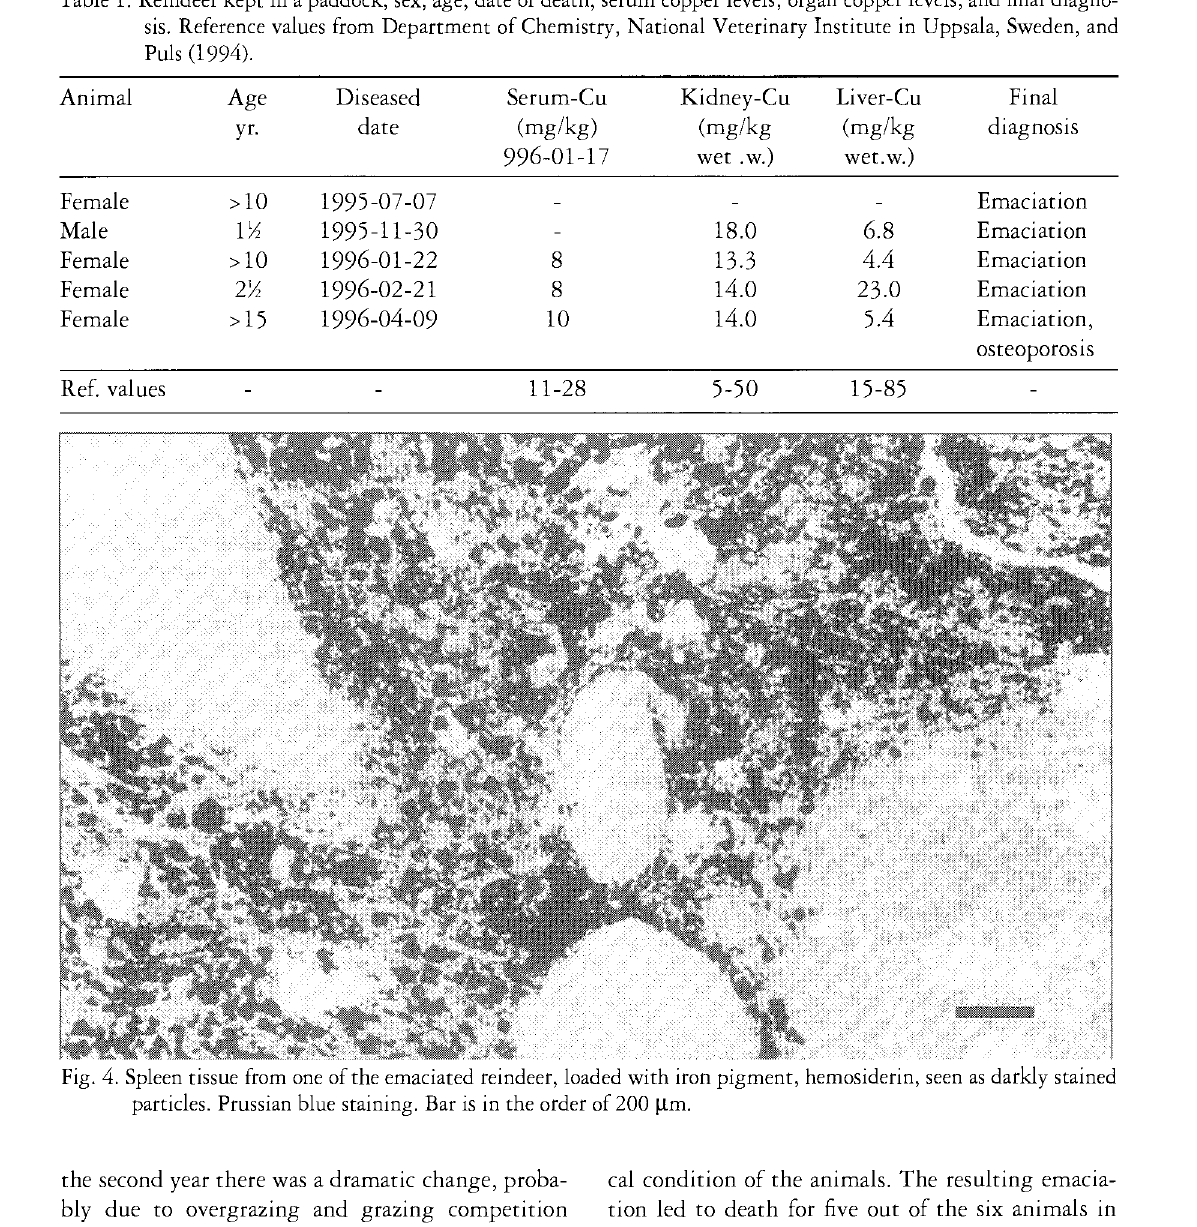
Table 1. Reindeer kept in a paddock; sex, age, date of death, serum copper levels, organ copper levels, and final diagno sis. Reference values from Department of Chemistry, National Veterinary Institute in Uppsala, Sweden, and Puis (1994).